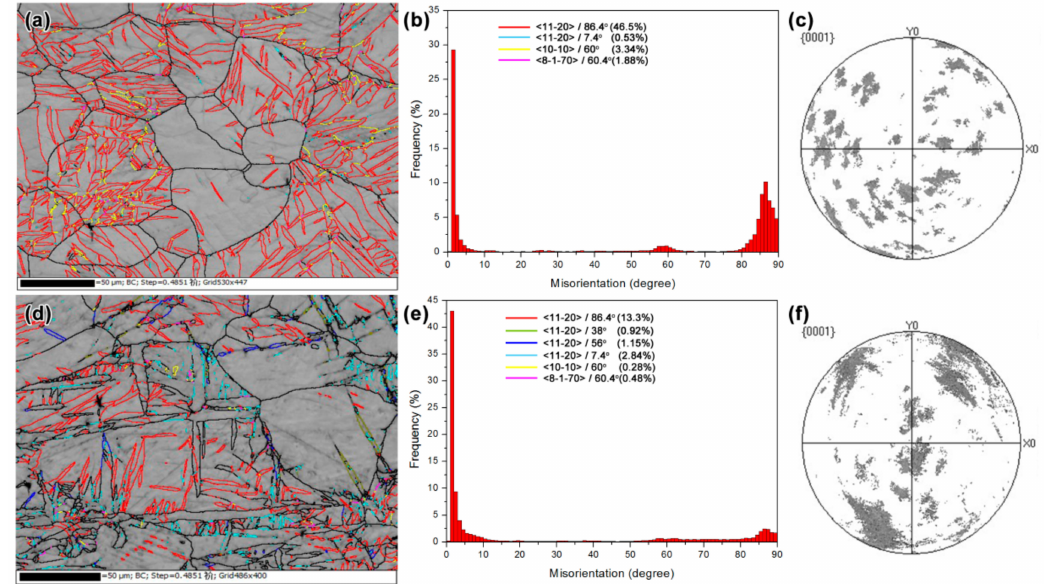
Figure 3. Showing the electron backscatter di ff raction (EBSD) band contrast maps of the distribution of twin and misorientation angle as well as the (0002) pole figures of the as-MAFed sample ( a – c ) and the deformed sample with a true tensile strain of 0.20 ( d – f